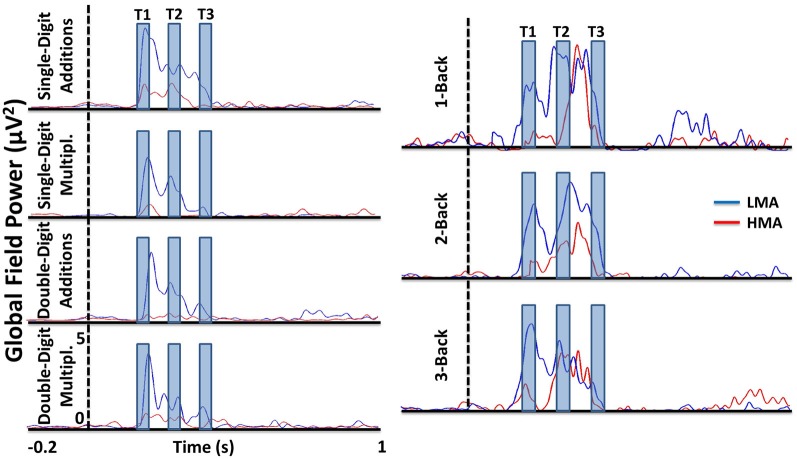
Global field power (GFP) waveforms in group level for each task separately showing that there are three time windows mainly which is used in the amplitude analyses. The GFP for each was computed for each task by considering only the cleaned trials.